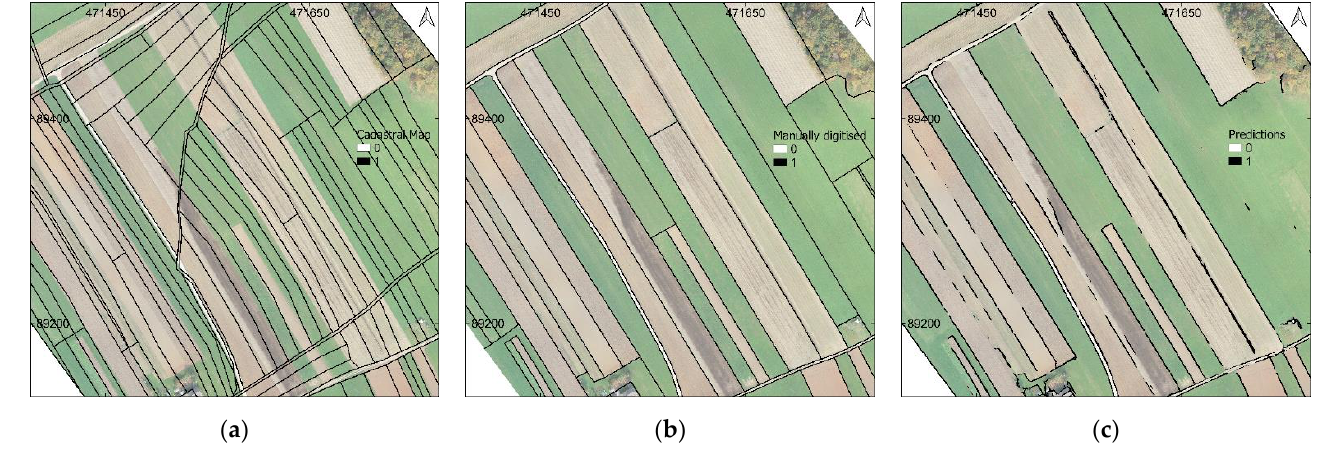
Figure 9. Revision of the cadastral map in Ponova vas: ( a ) Cadastral boundaries; ( b ) manually vectorised visible boundaries; and ( c ) predicted visible boundaries with customised CNN; ( a – c ) overlaid on UAV imagery. Table 5. Assessment of the overlap between cadastral boundaries and land visible boundaries— Ponova vas.